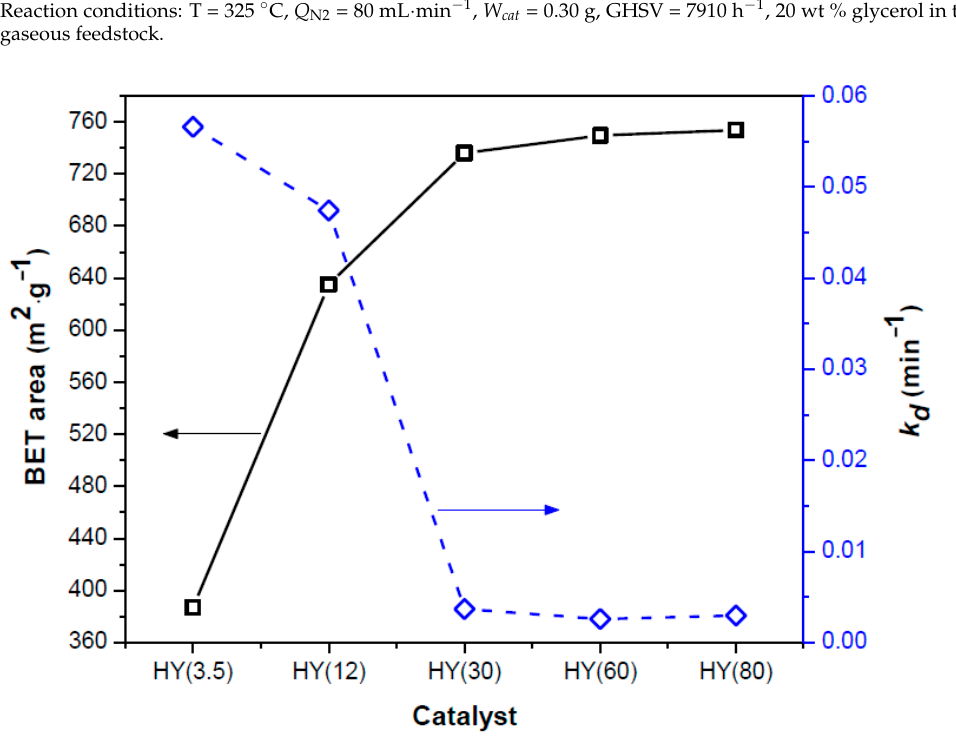
Figure 9. Comparison of the BET surface areas and the deactivation constants of the HY zeolites. It is noteworthy that the values of the deactivation rate constants for the